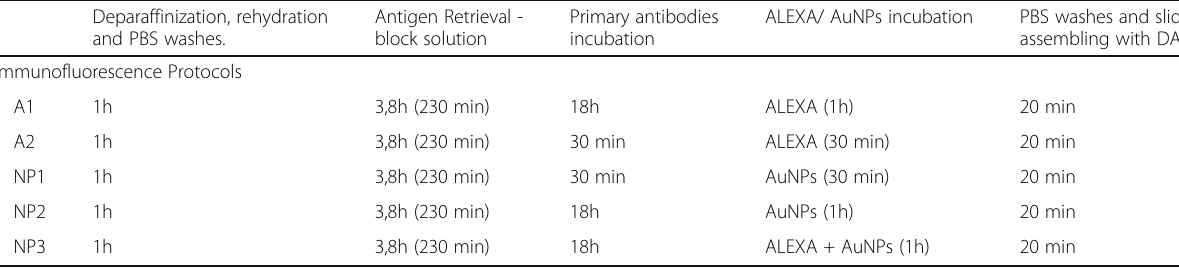
Table 1 Comparison of immunofluorescence protocols based on ALEXA and AuNPs Deparaffinization, rehydration and PBS